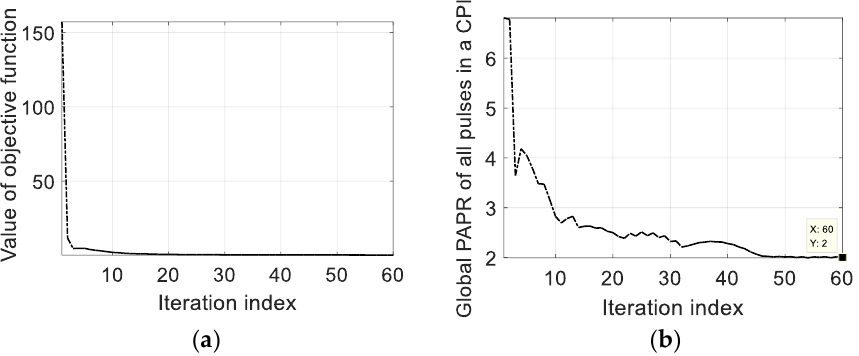
Figure 13. The convergence performance of POADMM and the variation of the global PAPR in the case of suppressing JRVDJ. ( a ) The convergence performance of the objective function using POADMM in the case of resisting JRVDJ. ( b ) The variation of the global PAPR in the case of resisting JRVDJ.